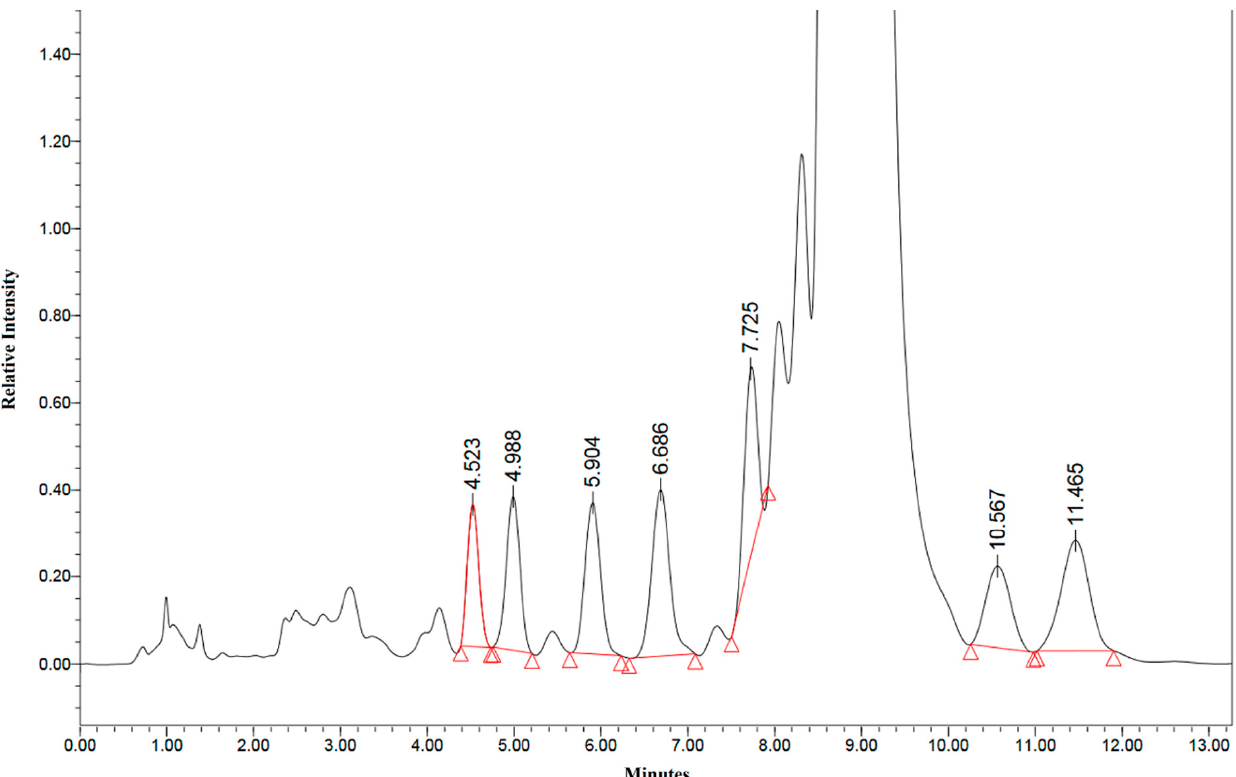
Figure 7. HPLC chromatogram of sample 6 performed during this study. A wavelength of 210 nm was used for the UV detector. The red triangles mark the range of a peak for integration.